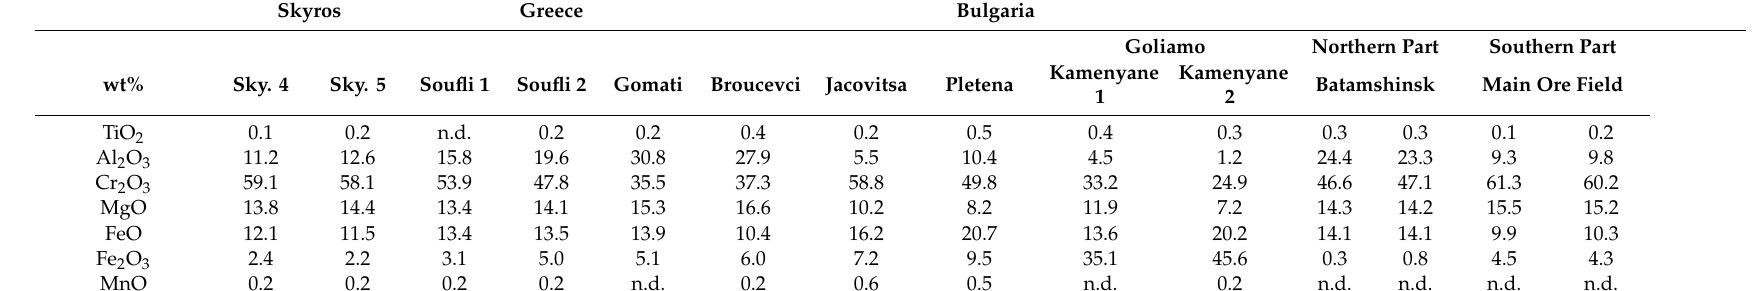
MnO 0.3 0.2 NiO 0.2 0.1 Total 100.3 Cr / (Cr +